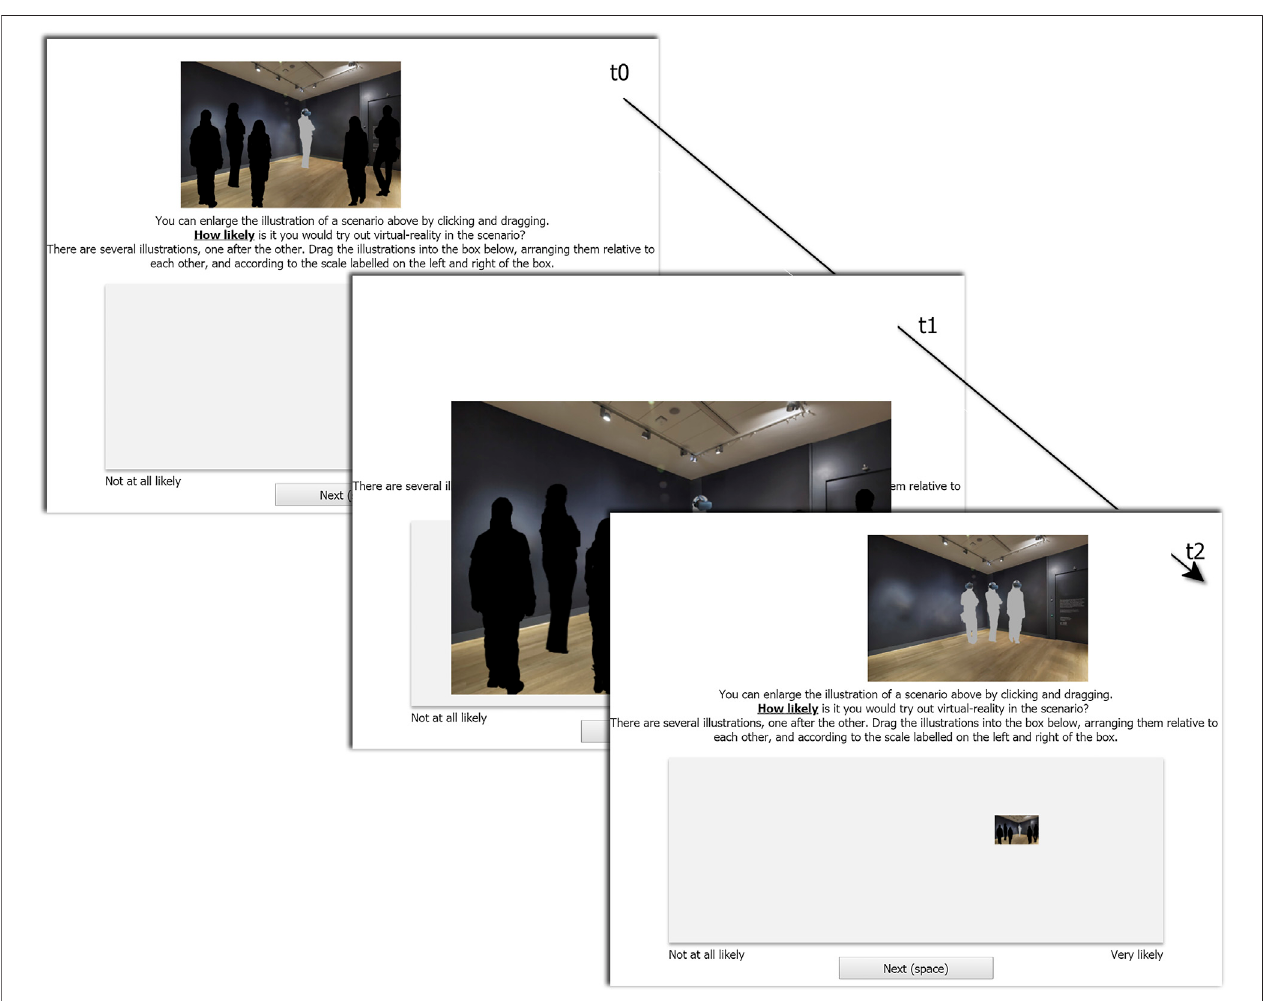
FIGURE4| Anillustrationoftheboxscaleproceduretime-course,fromleft(startoftrial)toright(afteroneimageplacement).Notehowtheimageismagni fi edwhen itisdraggedbythemouse(initiallyappearingathalfscale,zoomingtofullsize — 570 × 380pixels),tobeshrunkdownwhenplacedwithintheboxscale(10%size).Image size changes were “ smooth ” , occurring at a linear rate over a 0.2 s period. Labels t0, t1 and t2 are added to help illustrate element ordering.